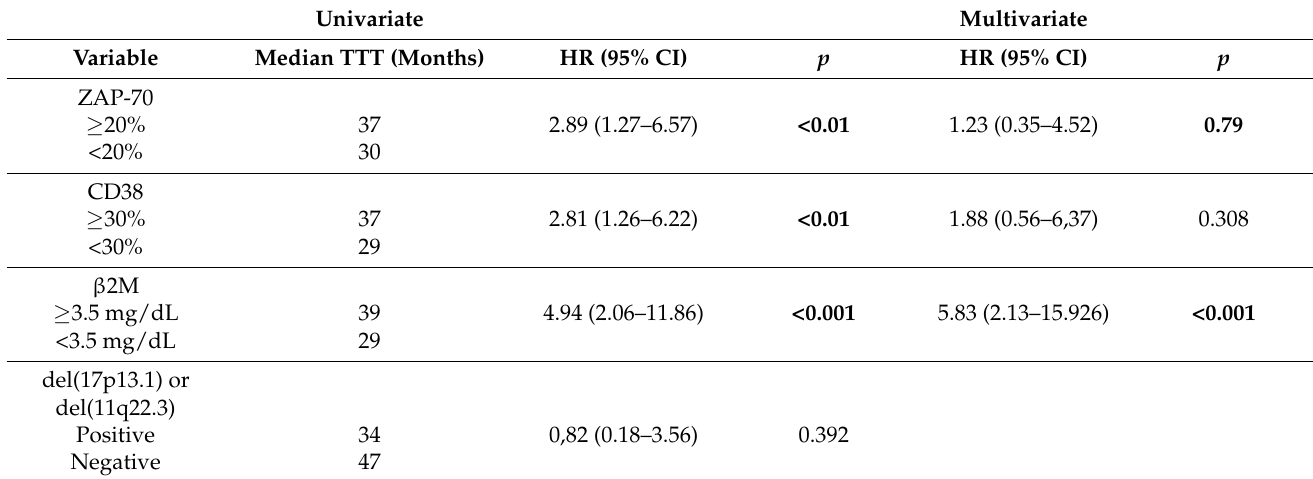
Table 2. Univariate and multivariate analysis for